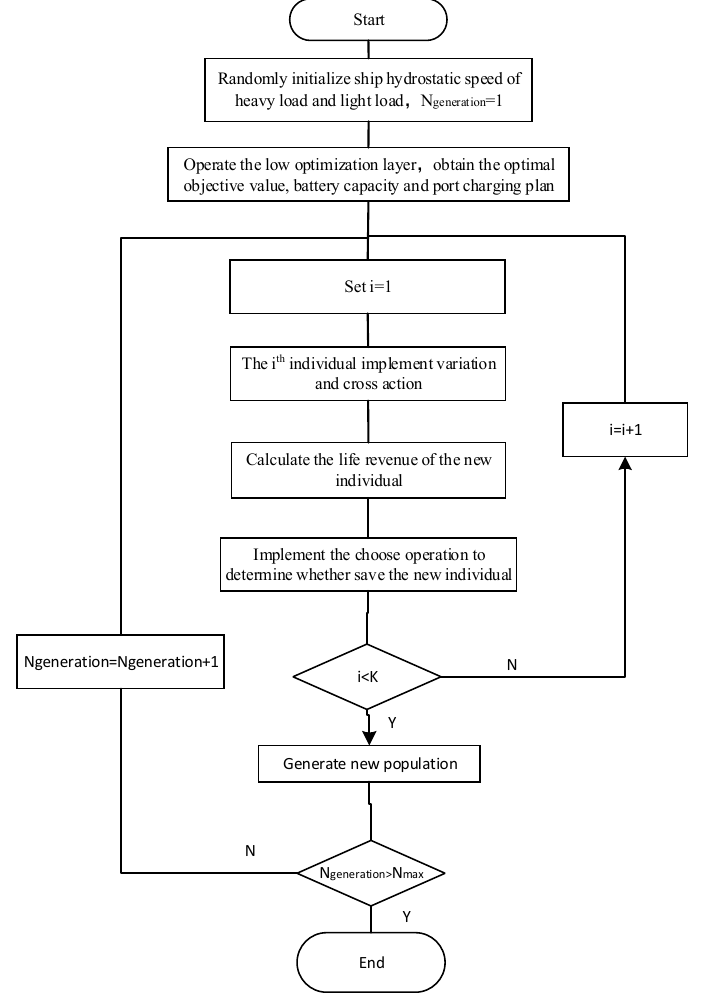
Figure 4. Solving framework of the proposed differential evolution algorithm.